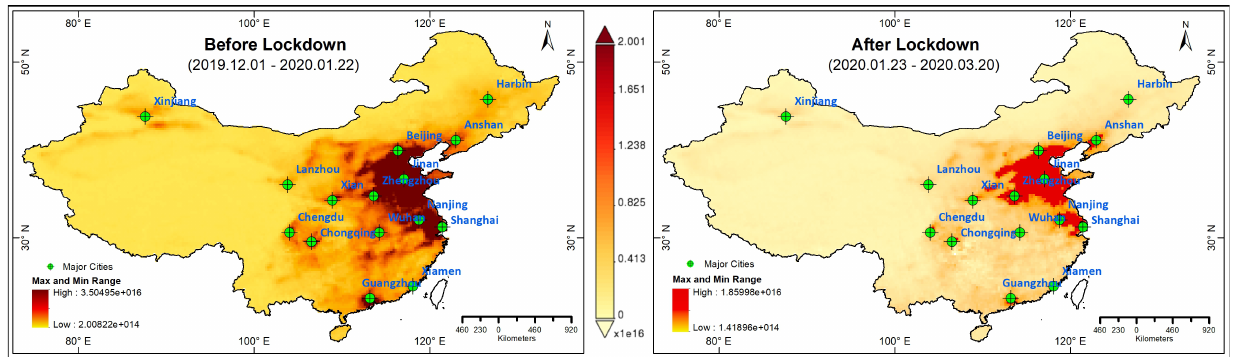
Figure 3. Time-average map of NO 2 tropospheric column (molecules/cm 2 ) of 15 major cities of China before and after the pandemic. Source: OMI, Global Modeling and Assimilation Office, NASA, 2020.